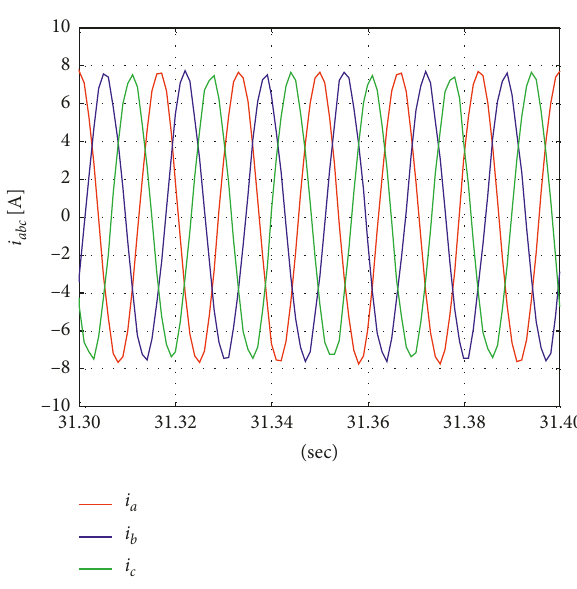
Figure 16: Experimental results of three-phase grid-current in CC